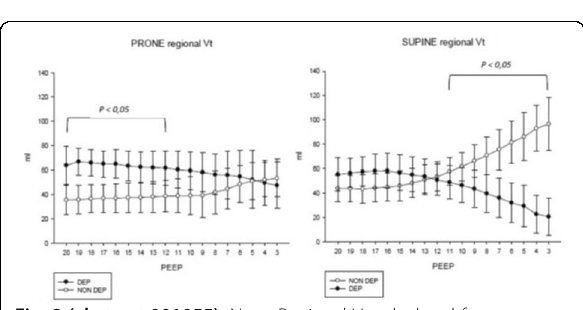
Fig. 2 (abstract 001055). Note: Regional Vt calculated from EIT(quadrant). Both SP and PP have interaction with PEEP (p <